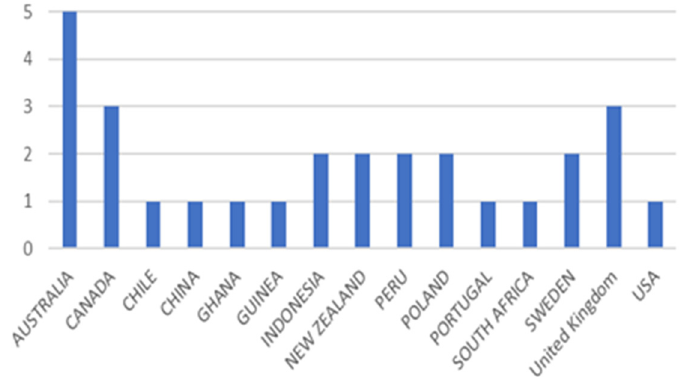
Figure 5. Authors’ countries.